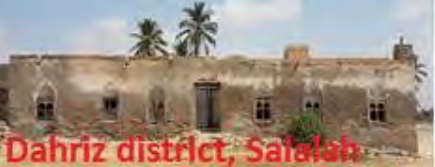
Figure 8. Fac¸ade’s photograph building location